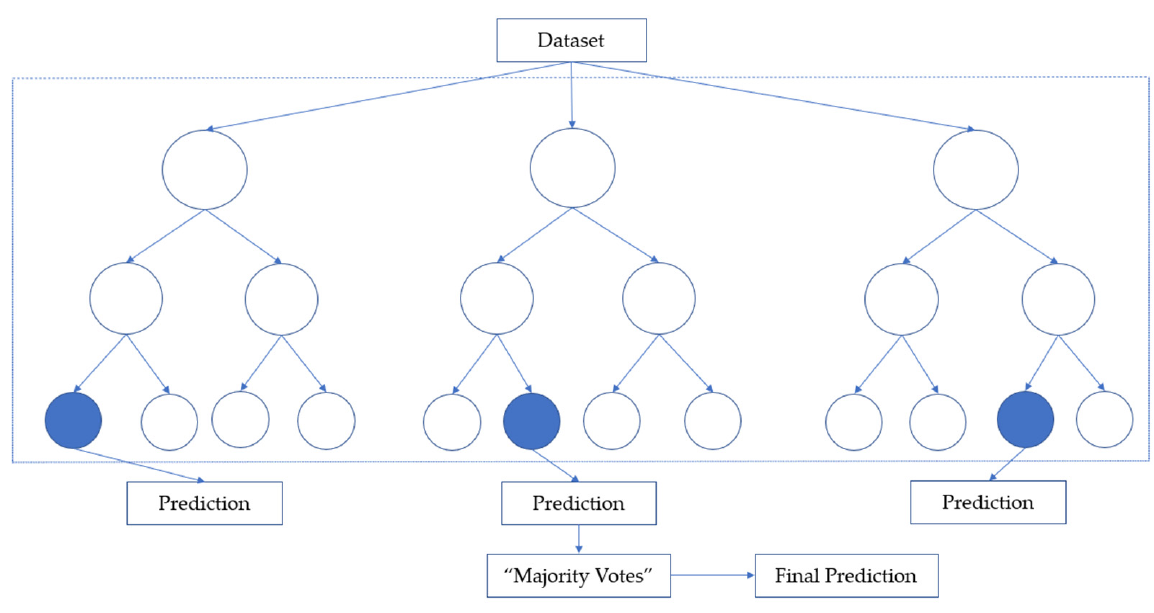
Figure 3. Random forest classifier.